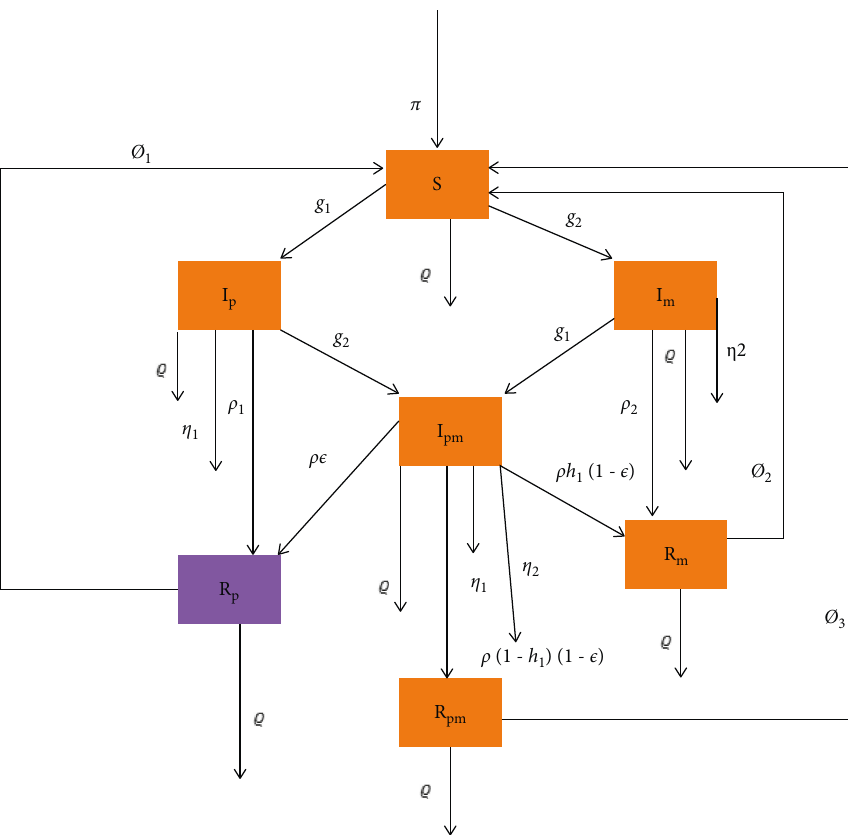
Figure 3: Flowchart for PM co-infection